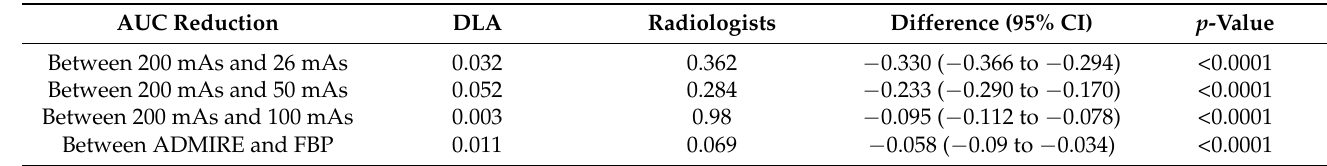
Table 4. Comparison of AUC reductions across imaging conditions for DLA and 12 radiologists in detecting 9 mm objects. AUC Reduction DLA Radiologists Difference (95% CI) p -Value Between 200 mAs and 26 mAs 0.032 0.362 − 0.330 ( − 0.366 to − 0.294) <0.0001 Between 200 mAs and 50 mAs 0.052 0.284 − 0.233 ( − 0.290 to − 0.170) <0.0001 Between 200 mAs and 100 mAs 0.003 0.98 − 0.095 ( − 0.112 to − 0.078) <0.0001 Between ADMIRE and FBP 0.011 0.069 − 0.058 ( − 0.09 to − 0.034) <0.0001 Data are the AUC with 95% CIs in parentheses. p -value < 0.0125 was considered as statistically significant. AUC = area under receiver operating characteristics curve, CI = confidence interval, DLA = deep learning algorithm, FBP = filtered back projection, ADMIRE = advanced modeled iterative